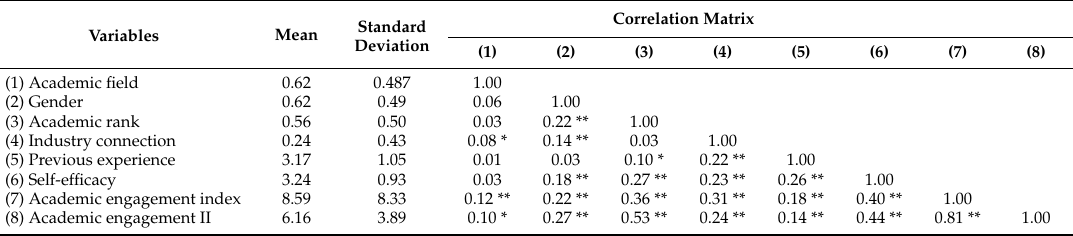
Table 2. Descriptive statistics and correlations.